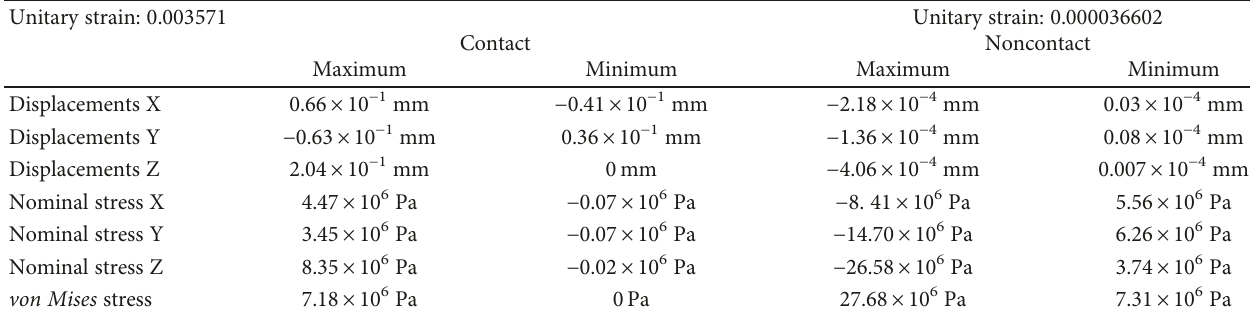
Table 4: Simulation results for a load of 100 N/mm 2 .